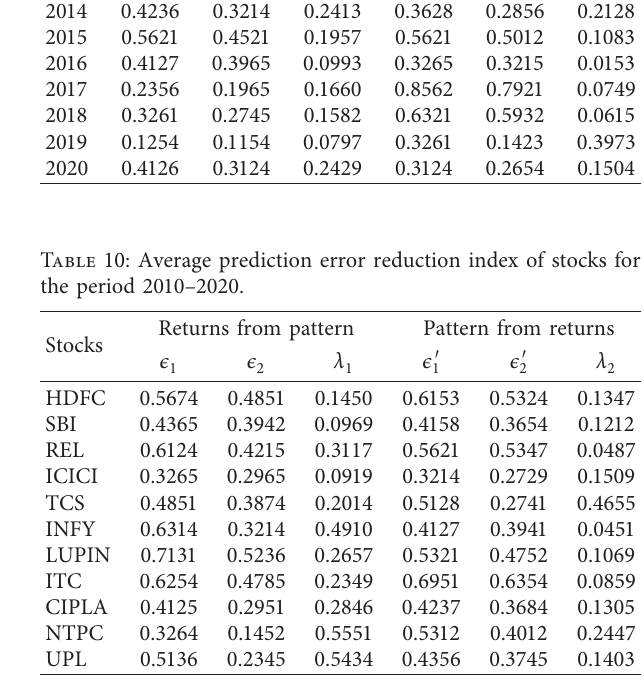
Table 6: Two-variable